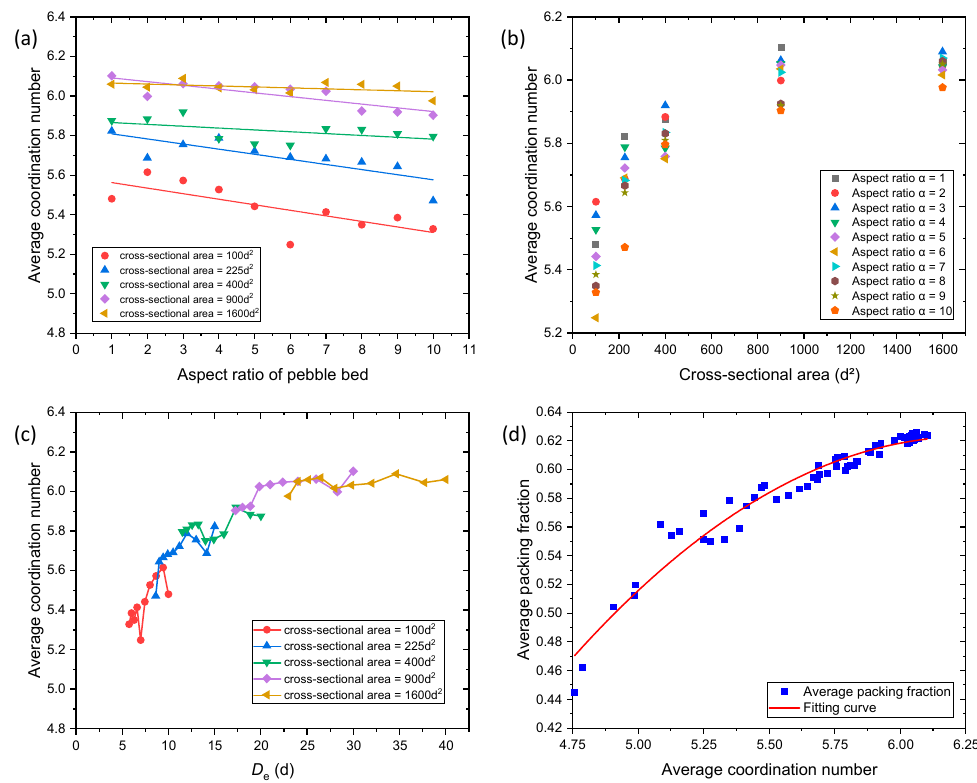
Figure 14. Average coordination number of the rectangular pebble bed: ( a ) variation as aspect ratio, ( b ) variation as cross-sectional area, ( c ) variation as De, ( d ) relationship between the CN avg and the γ avg of the rectangular pebble beds.